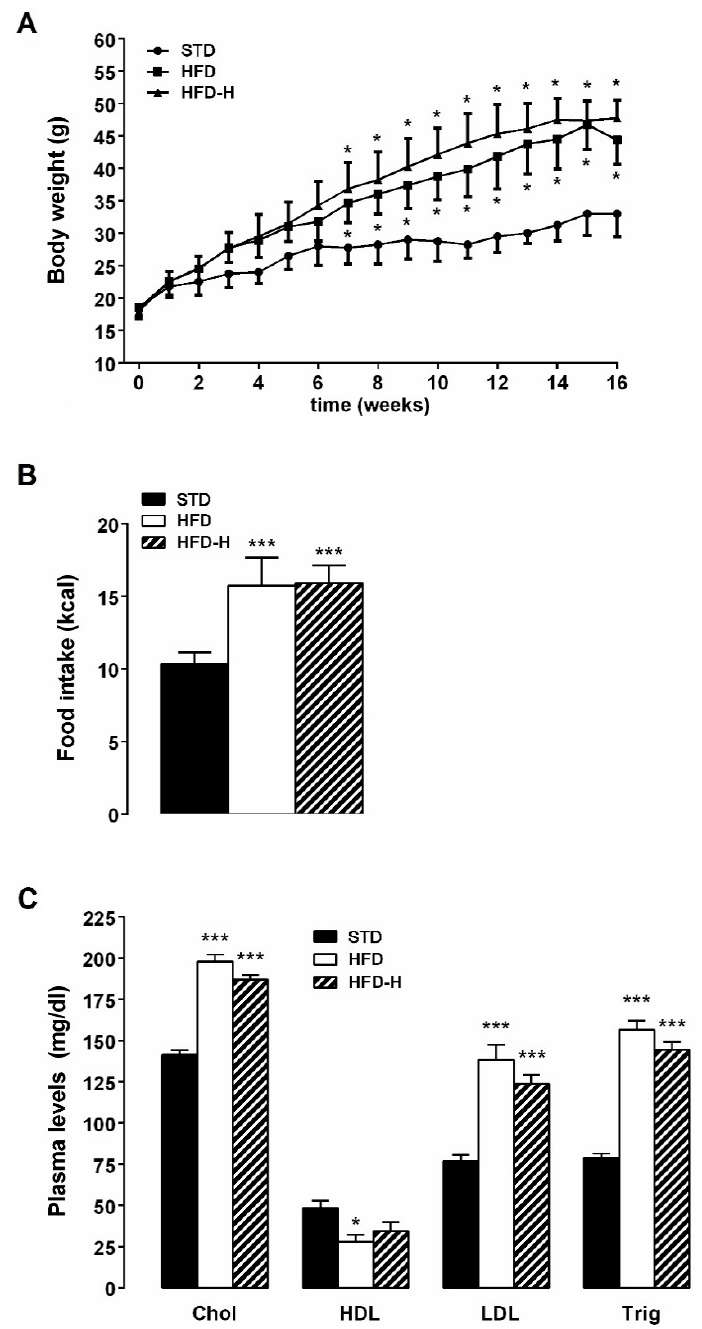
Figure 1. Effects of long-term honey ingestion on metabolic parameters in HFD mice. Honey failed to prevent weight gain and dyslipidemia in HFD mice. ( A ) Bodyweight; ( B ) Daily food intake; ( C ) Plasma concentrations of triglycerides, cholesterol, HDL and LDL in the different groups of mice. Data are mean values ± S.E.M. ( n = 8/group). * p < 0.05, *** p < 0.001 vs. STD mice.